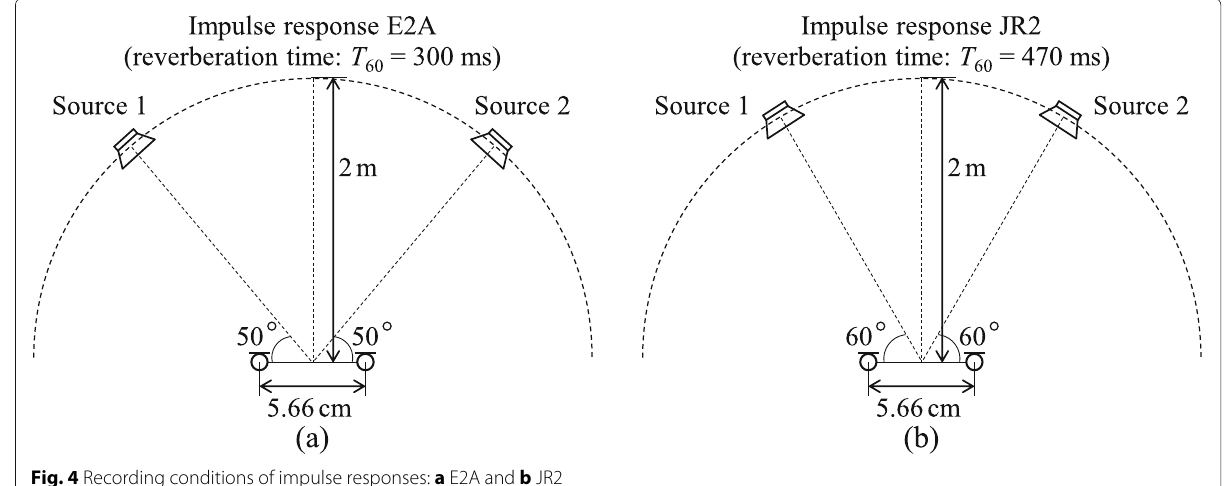
methods, the nonnegative matrices T n and V n were ini- tialized using uniformly distributed random values in the range ( 0, 1 ) . Five trials were performed for each condition using different pseudorandom seeds. The number of bases for each source, K , was set to 10 for music mixtures